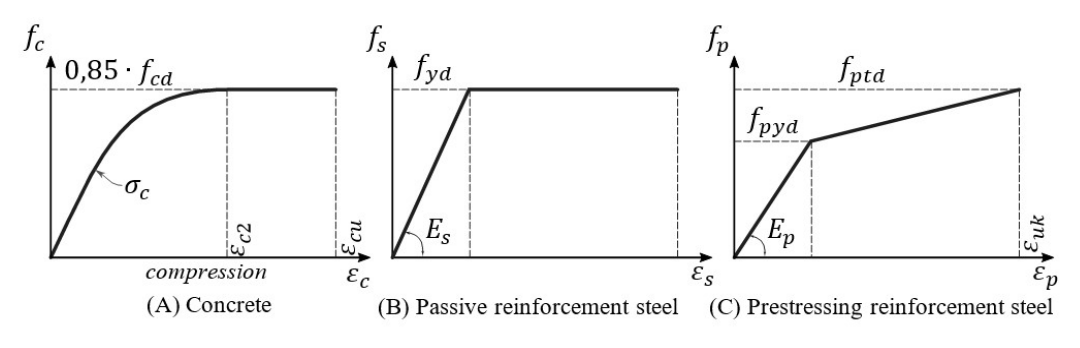
Figure 2. Stress-strain relationship of the